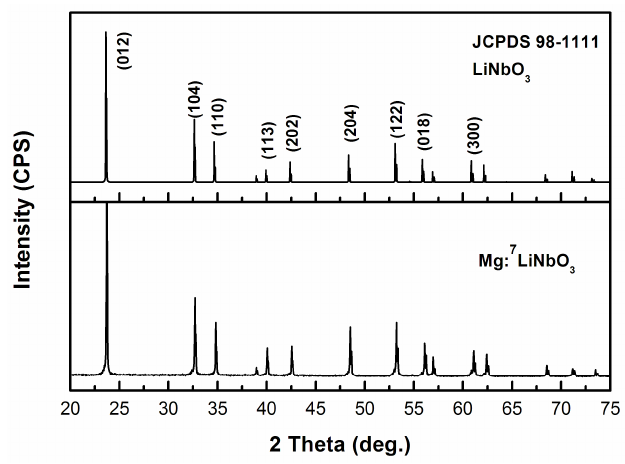
Figure 2. X-ray powder diffractometer (XRPD) pattern of the Mg: 7 LiNbO 3 crystal.